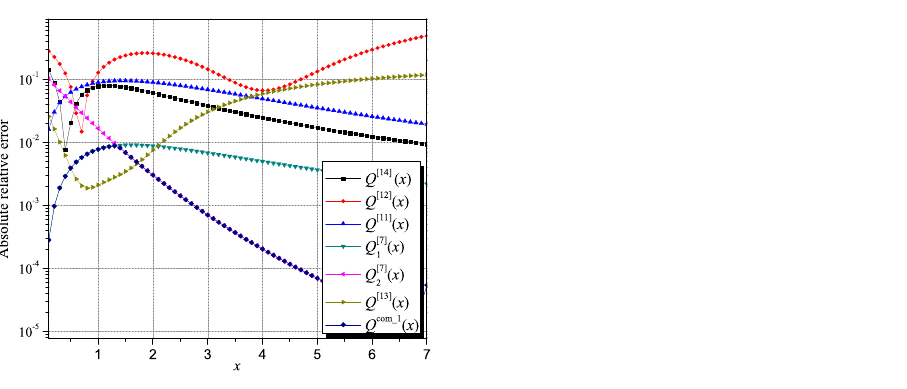
Figure 2. The comparison of the absolute relative errors of the first interval upper-bound approxima- tion of the Q -function and selected ones from the literature [7,11–14].